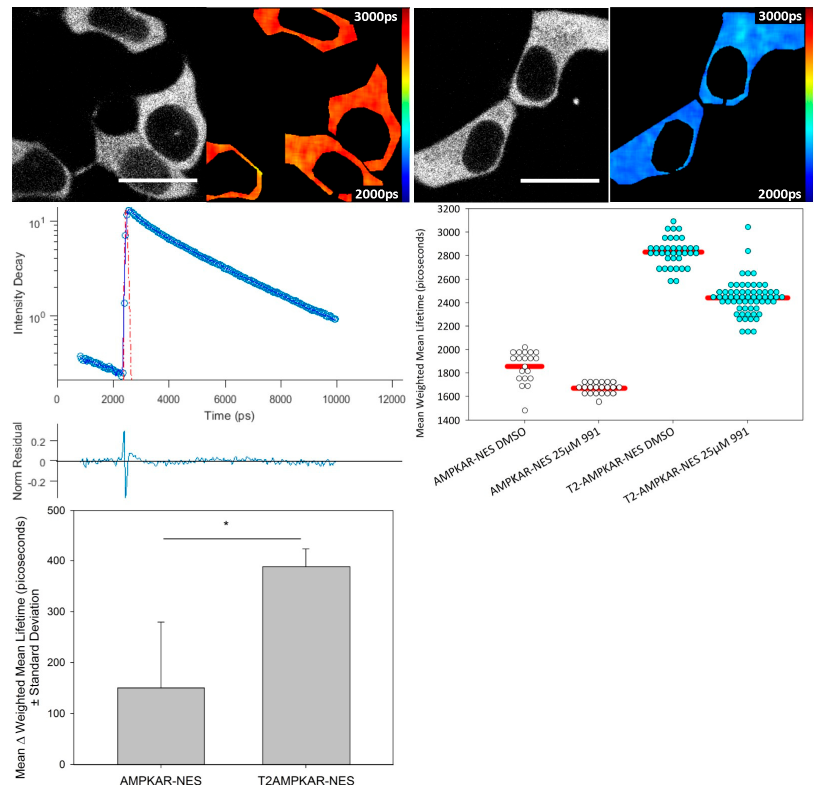
Figure 2. Confocal TCSPC FLIM of AMPKAR-NES and T2AMPKAR-NES. Top panel , exemplar intensity images and lifetime maps of T2AMPKAR-NES for both DMSO exposed ( Left ) and 25 µM 991 activated ( Right ) cells are shown; Middle left panel : exemplar fluorescence decay profile (blue circles) plotted with double exponential fit to data (blue line), IRF (red dashed line) and residuals (lower); Middle right panel , data shown are from three separate experiments. Fluorescence lifetimes for individual cells are shown in dot plot; Lower left panel , mean difference in biosensor mean weighted fluorescence lifetime (n = 3). Lifetimes are shown in picoseconds (shown in image). Scale bar = 20 µm.